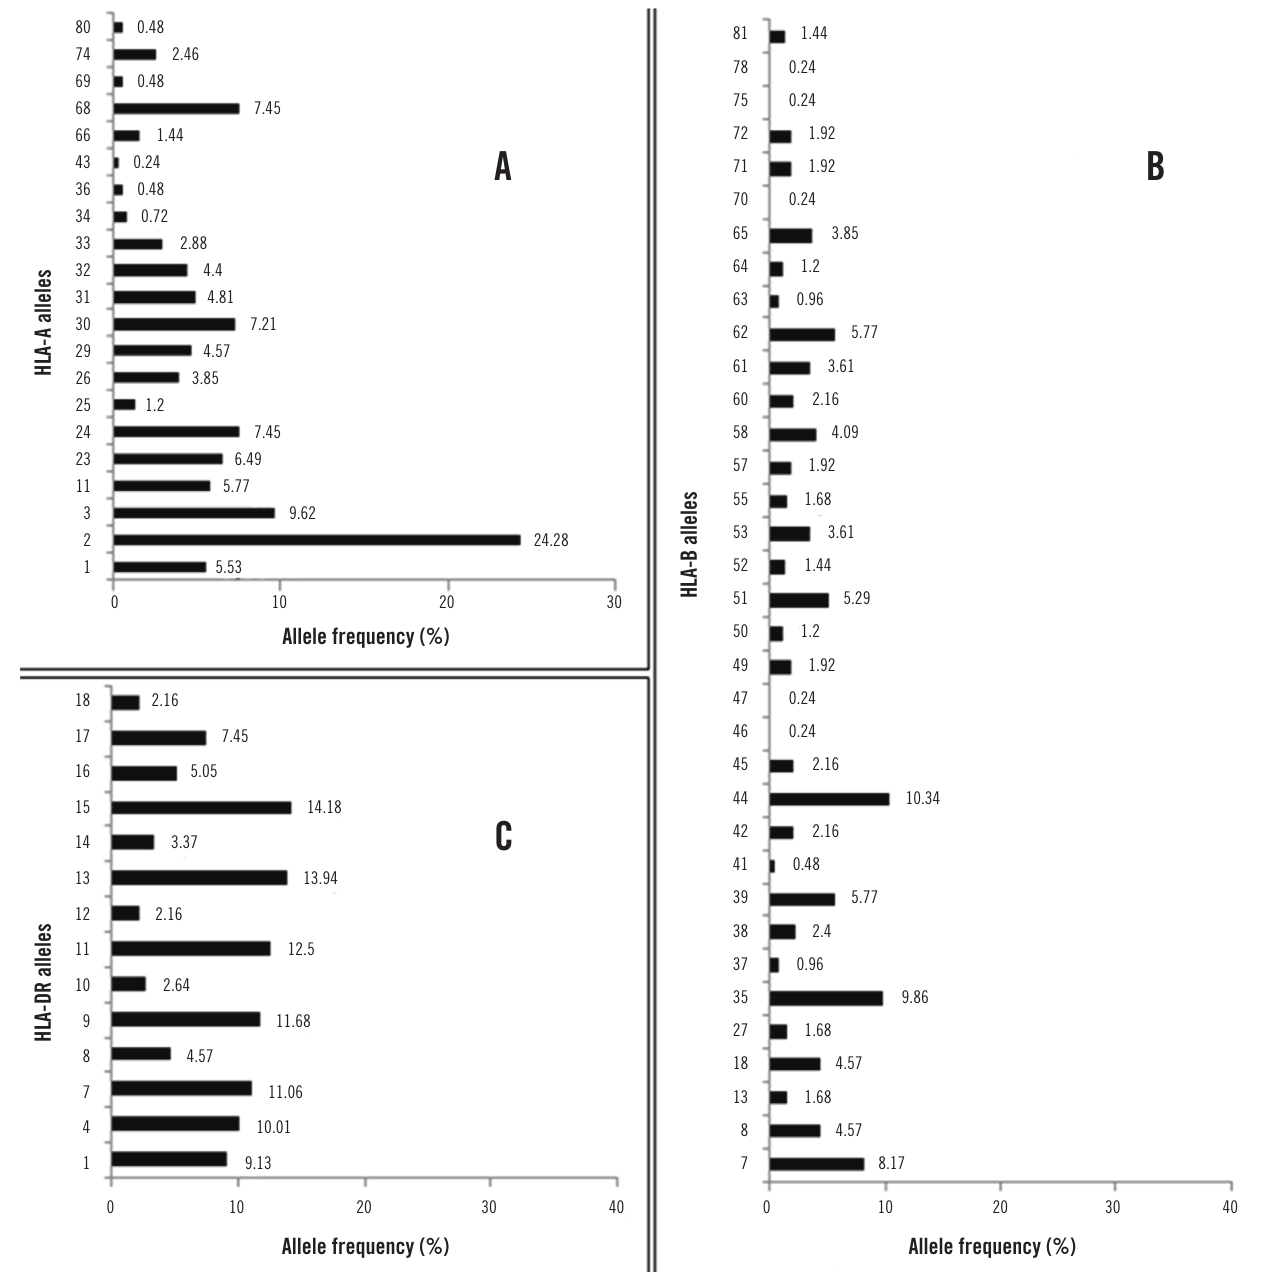
figurE − HLA allele frequency (A: HLA-A; B: HLA-B; C: HLA-DR) in deceased donors of solid organs ( n = 208) in the state of Espírito Santo, Brazil, from 2011 to 2015 HLA: human leukocyte